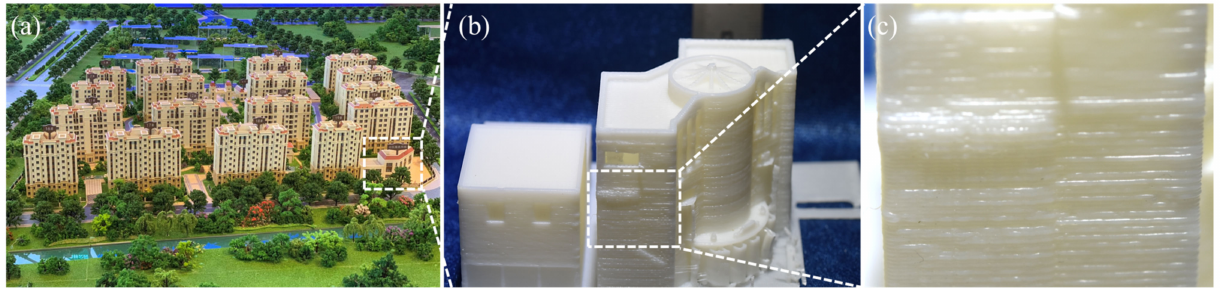
Figure 1. Landscape design photographs of a 3D-printed PLA model set of buildings in Qinhuangdao, China: ( a ) model set of landscape design and buildings; ( b , c ) locally enlarged